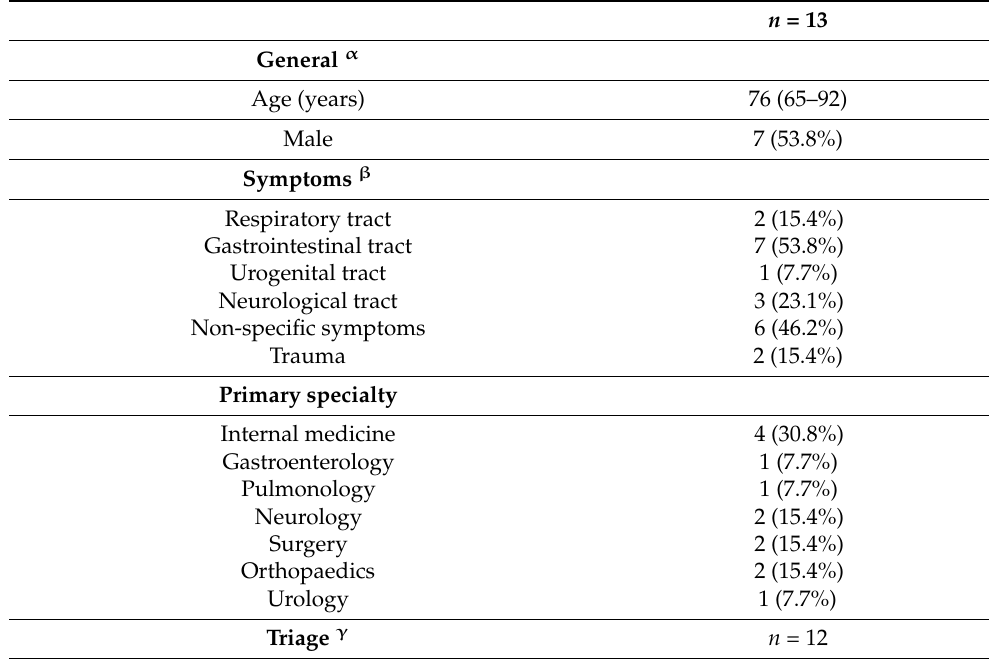
Table 3. Baseline characteristics of the 13 COVID-19 RT-PCR positive patients initially allocated to